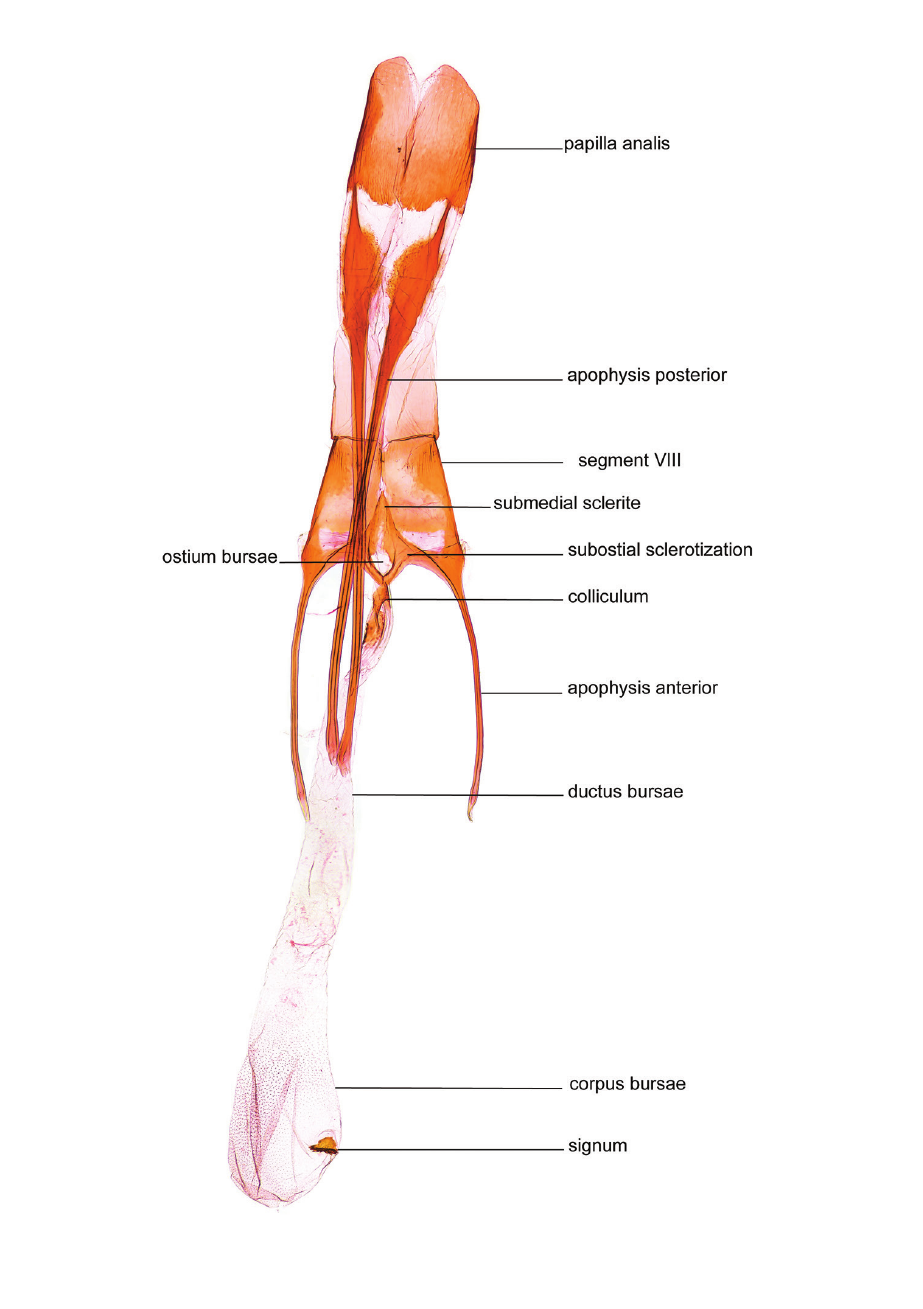
Figure 5. Terminology of important characters in female genitalia of Megacraspedus niphorrhoa (Meyrick,